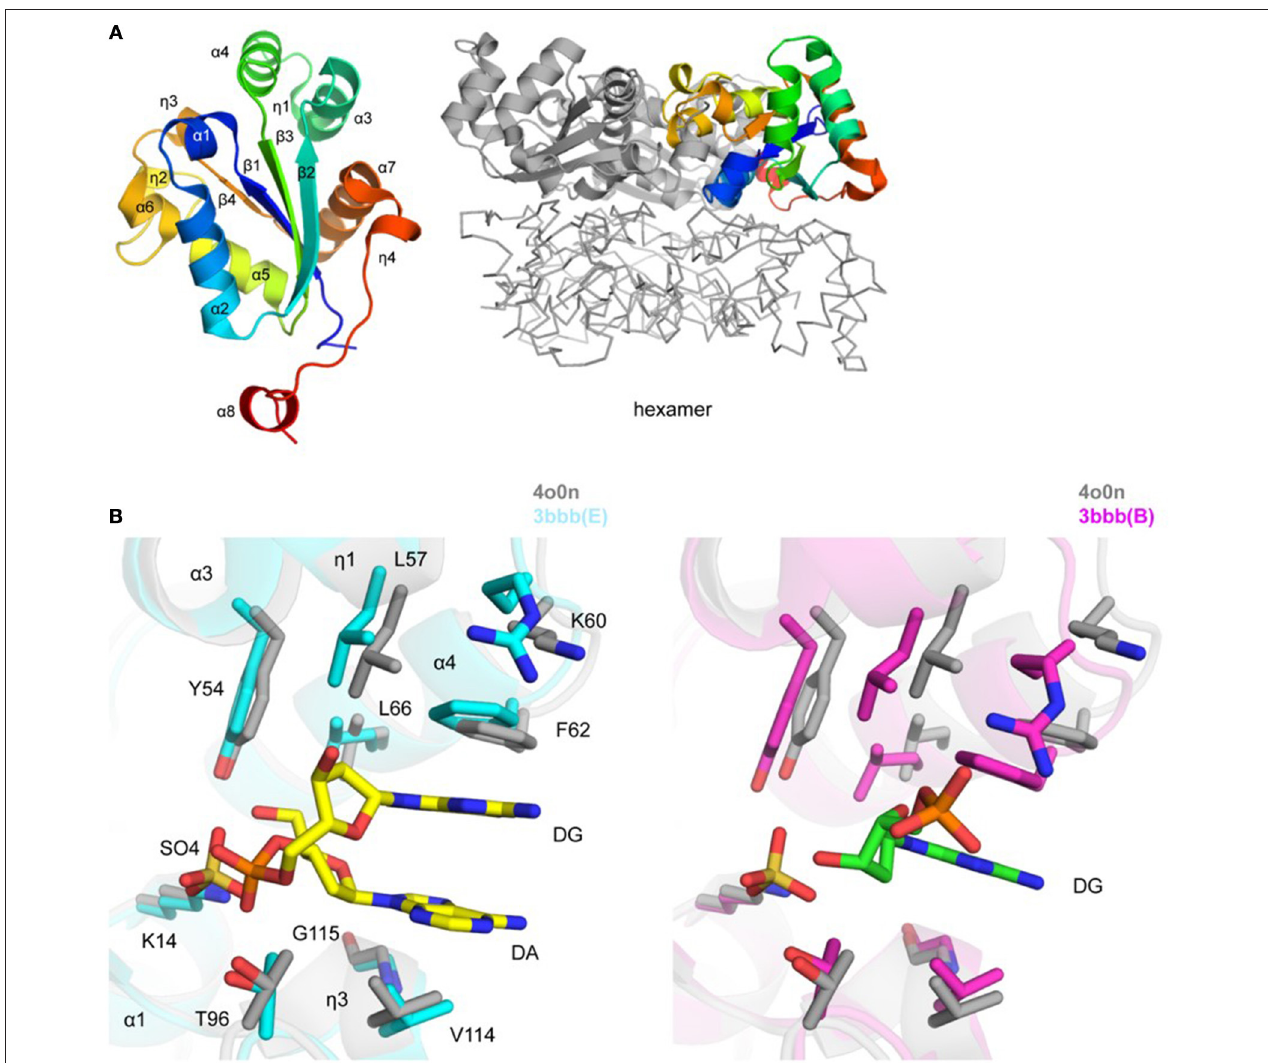
FIGURE 3 | Crystal structure of Tg NDK (A) . Ribbon representation of Tg NDK monomer (left side) colored blue (N-terminus) to red (C-terminus) and trimeric and hexameric assemblies of Tg NDK (middle and right side) (B) . Pairwise structural alignment of Tg PGM (gray; SO4 is shown in sticks) and human NM23-H2 transcription factor [cyan (chain E with bound 2 ′ -deoxyguanosine-5 ′ -monophosphate (DG) and 2 ′ -deoxyadenosine-5 ′ -monophosphate (DA)] and magenta [chain B with bound 2 ′ -deoxyguanosine-5 ′ -monophosphate (DG)] showing active site with residues of Tg NDK shown in sticks and labeled in one-letter code. Equivalent residues of human NM23-H2 transcription factor are